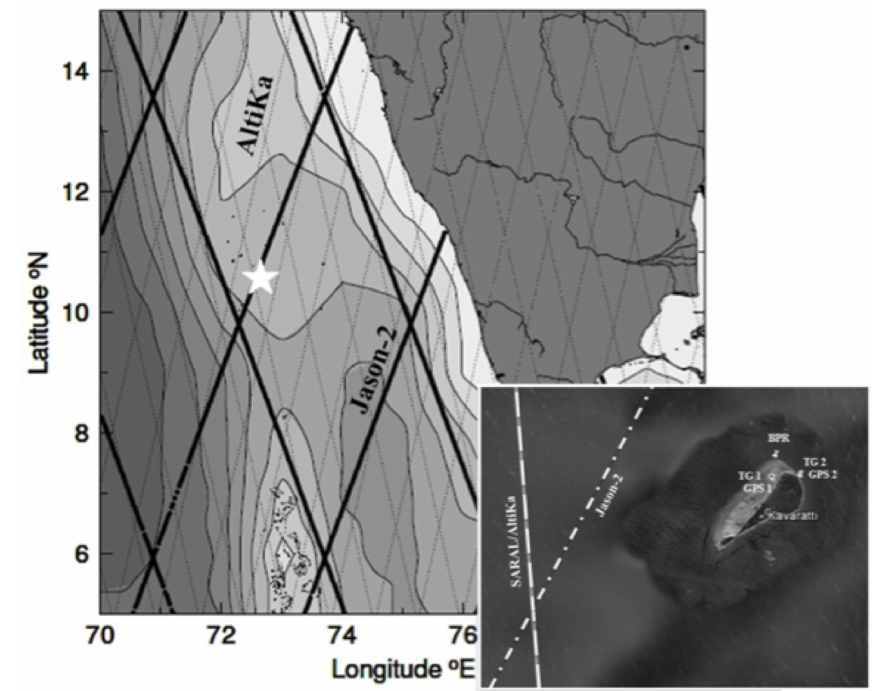
Figure 3. The large map shows the location of Kavaratti island (star) as well as the Jason-2 and SARAL/AltiKa ground tracks. The insert is a zoom of Kavaratti: ISRO’s altimeter calibration site, has dual radar tide gauge station and a bottom pressure recorder.